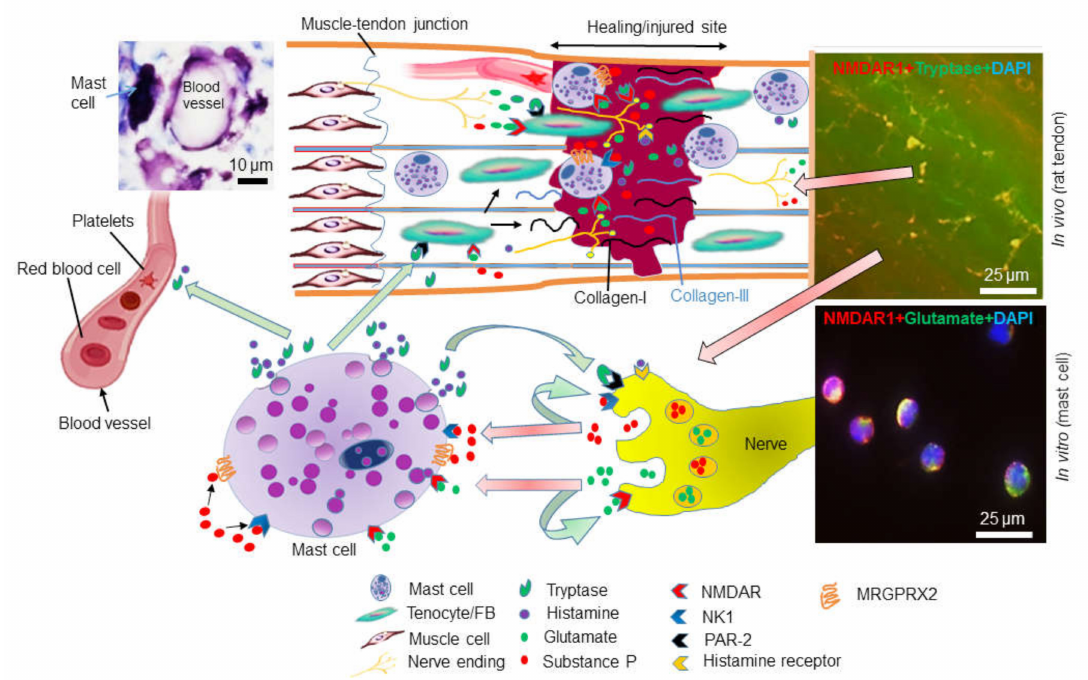
Figure 3. A possible role of mast cells in regulating the inflammatory and healing responses in the injured tendon. After tendon injury, peripheral nerve endings can release neuropeptides, e.g., glutamate and substance P, that may activate mast cells or fibroblast-like cells (tenocytes) via their respective receptors, e.g., glutamate receptors (e.g., NMDAR1) NK1 and MRGPRX2. Activated tenocytes can proliferate and increase their type-I and type-III collagen synthesis during tendon healing. Activated mast cells can release proteases, e.g., tryptase, which may have a functional impact on tendon cells or may activate nearby nerves via PAR-2. Mast cells can also activate nerves via their release of histamine, which can bind to histamine receptors on nerve endings. Further, mast cells can also a ff ect angiogenic processes. The upper right panel shows the colocalization of NMDAR1 with tryptase in vivo in injured tendon; the lower right panel shows colocalization of glutamate and NDMAR1 in glutamate-stimulated mast cells. The upper left image depicts the close localization of mast cells to blood vessels in injured